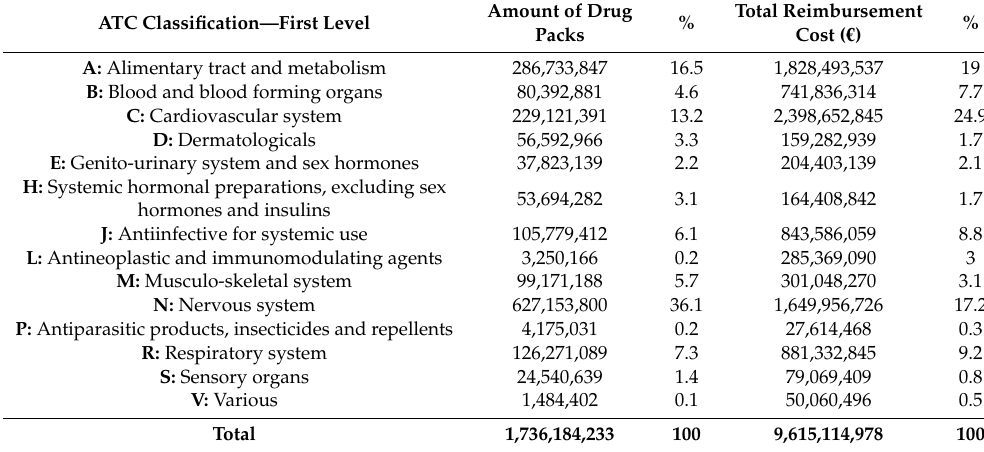
Table 1. Anatomical Therapeutic Chemical (ATC) classification (1st Level) and total reimbursement cost in France in